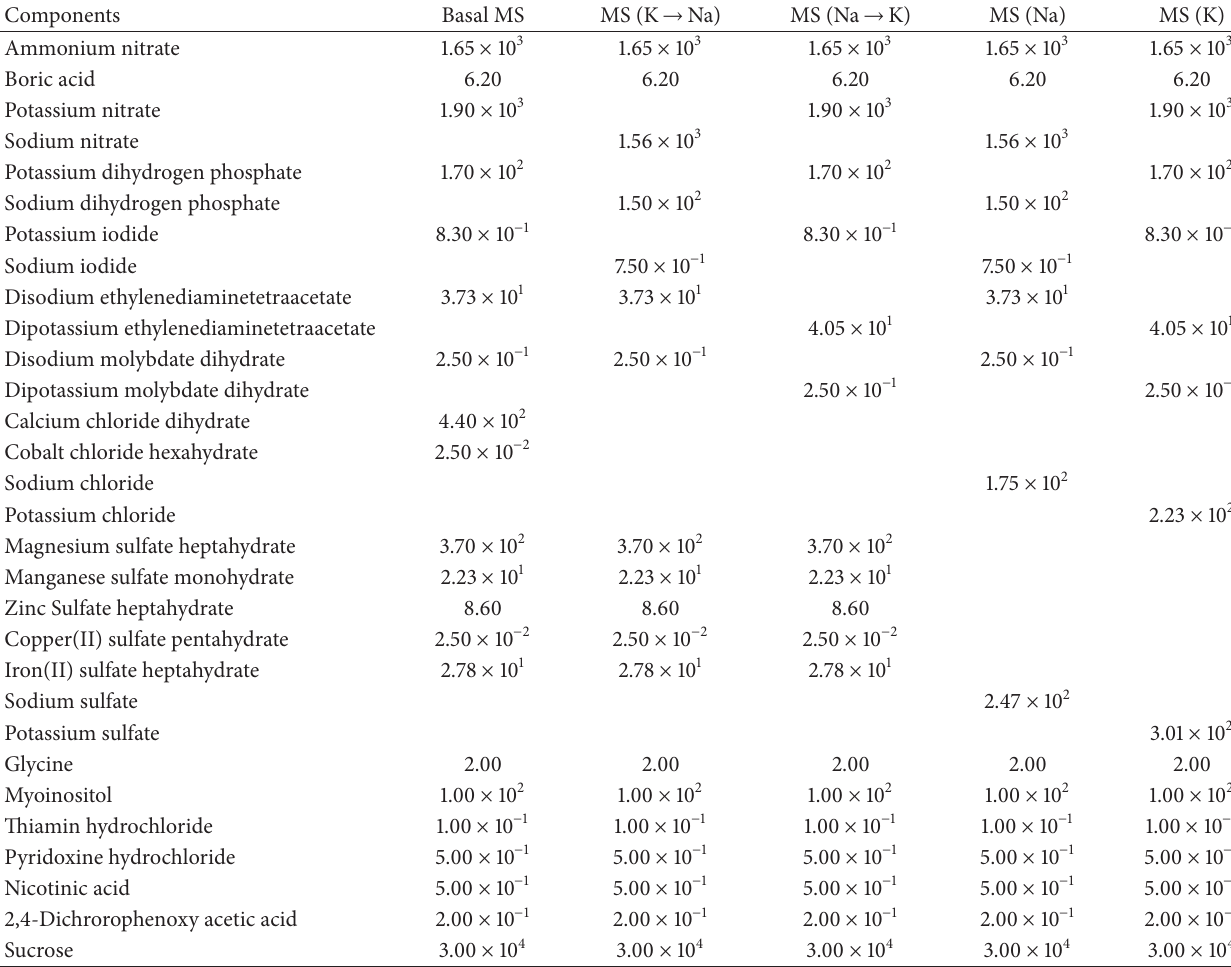
Table 1: Composition of basal MS medium and modified MS